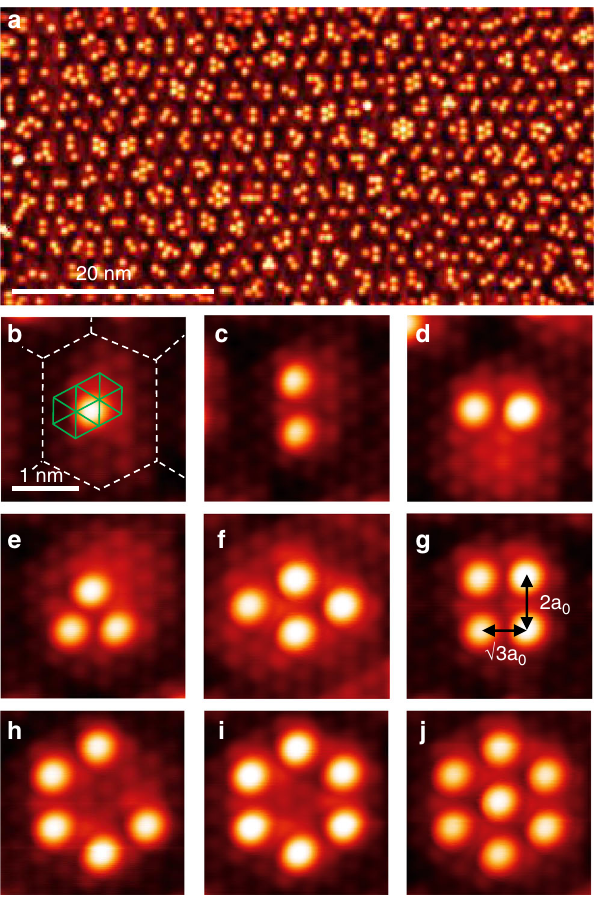
Fig. 1 STM topography of Pb clusters on IrTe 2 . a A typical IrTe 2 surface decorated with Pb adatoms in the hexagonal charge order state (V s = 1.5 V, I t = 0.05 nA). Scalebar, 20 nm. b – j Various Pb clusters are observed on a single hexagon (V s = 20 mV, I t = 1 nA): b monomer (Scalebar, 1 nm), c 2a 0 - ffiffiffi p ffiffiffi p spaced dimer, d 3 a 0 -spaced dimer, e 3 a 0 -spaced trimer, f 2a 0 -spaced tetramer, g mixed-spacing tetramer, h 2a 0 -spaced pentamer, i 2a 0 -spaced hexamer, and j 2a 0 -spaced heptamer. Green solid lines and white dashed lines in b denote the Te-(1 × 1) lattice and the charge-order hexagon lattice,